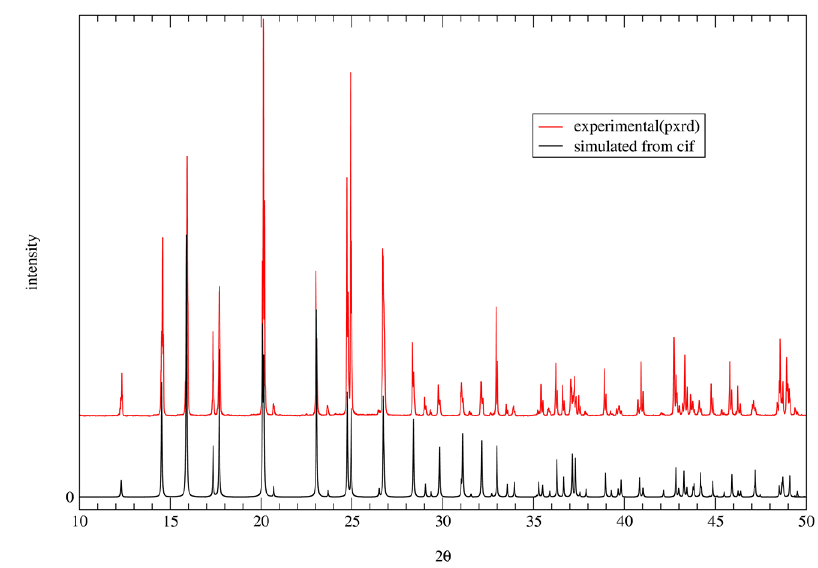
Figure 1. PXRD diffractograms of crystalline LAlaRe (bottom) and a simulation from the model structure